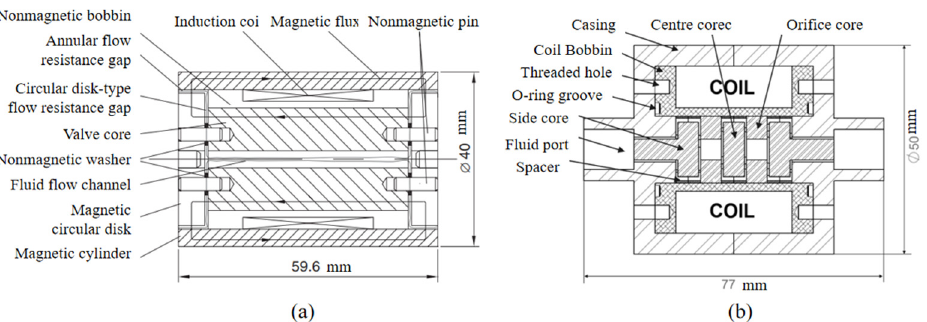
Figure 12. MR valve with annular-radial damping channel: ( a ) Disc type combined flow channel MR valve [71]. ( b ) Curved flow path MR valve